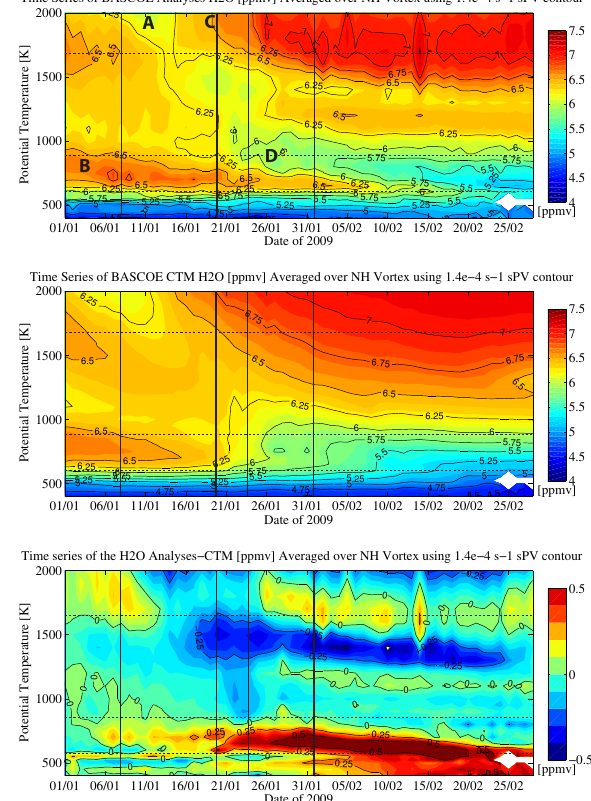
Fig. 7. Times series of NH vortex-averaged water vapour (ppmv) for 1 January–28 February 2009 and theta range 400K–2000 K. (Top) From BASCOE analyses; (Middle) from BASCOE CTM run (no assimilation), with chemistry; (Bottom) difference between top and middle plots. In top and middle plots, blue-green denotes rel- atively low values; red denotes relatively high values. In bottom plot, red denotes positive differences (analyses values higher than CTM values), blue denotes negative differences (analyses values lower than CTM values). The vortex average is computed for PV values identified to be within the polar vortex. The vortex edge is defined using the 1.4 × 10 − 4 s − 1 scaled PV discussed in Manney et al. (2007). The white area indicates where it is not possible to cal- culate the vortex edge. The vertical black solid lines identify dates 8, 20 and 24 January, and 1 February (left to right). The horizontal black dashed lines identify theta levels 550 K, 850K and 1700K (bottom to top). A, B, C and D marked in the top plot identify features discussed in the text, and mentioned in Table 1 (for A, B and